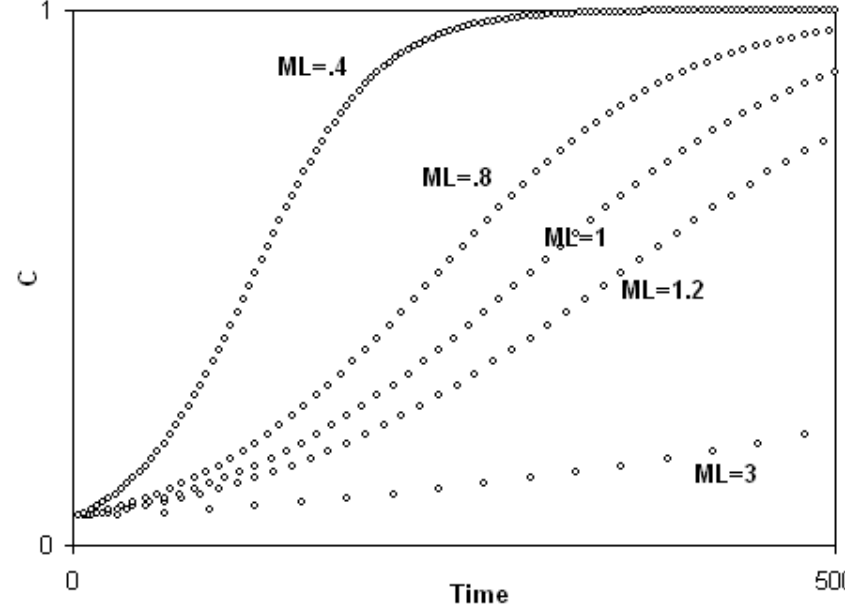
FIGURE 7. Spreading of a gene according to the variation of ML. The abscissas indicate the time and not the generations. The advantage S has a constant value (k = 0.01) for all the five curves, while ML has the following different values: ML 1 = 0.4; ML 2 = 0.8; ML 3 = 1; ML 4 = 1.2; ML 5 = 3. The values of ML are given by the formula: ML i = k/S i , where S i indicates an S value in the curves of the previous figure and k is the same value of S 3 in the previous